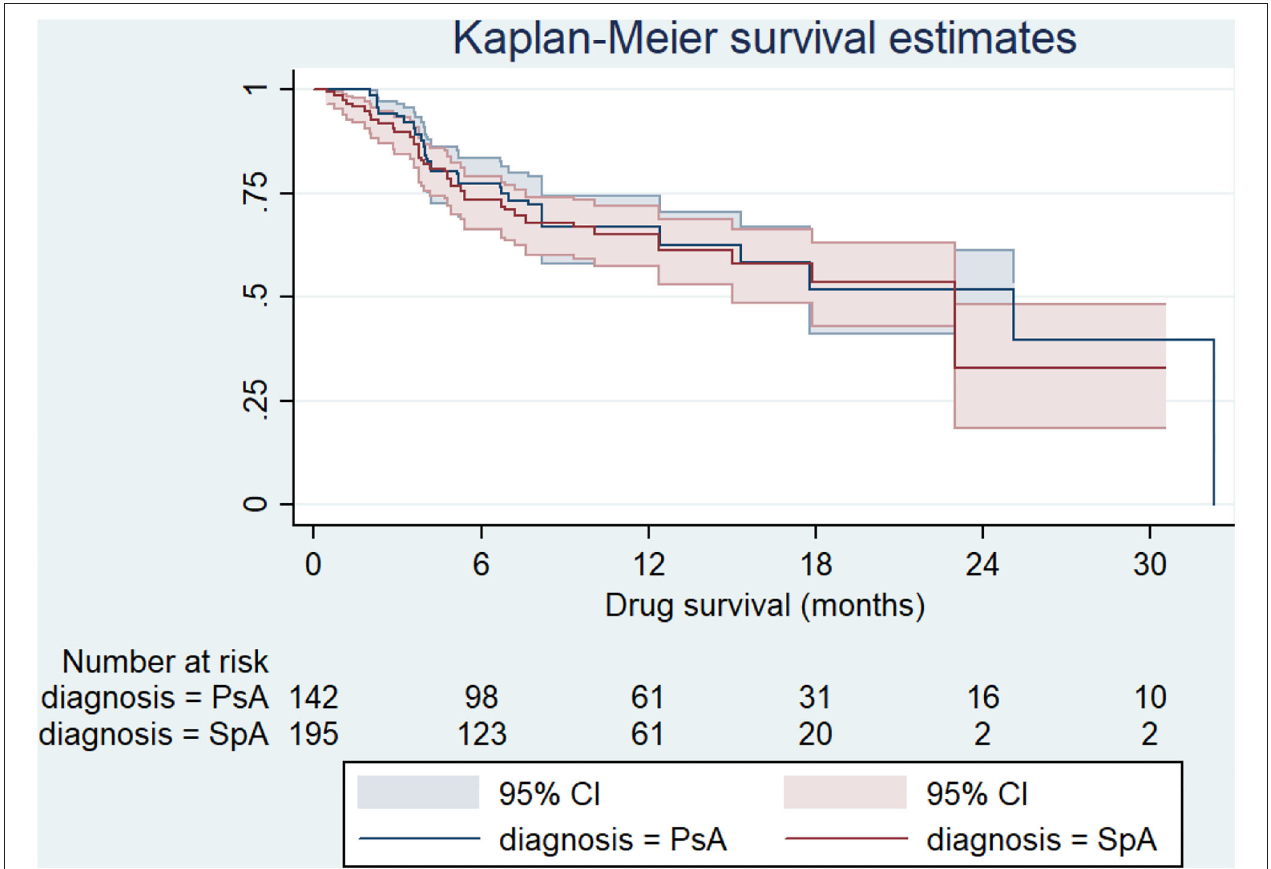
FIGURE 1 | Survival curve of secukinumab by disease types. PsA, Psoriatic arthritis; SpA, Spondyloarthritis.